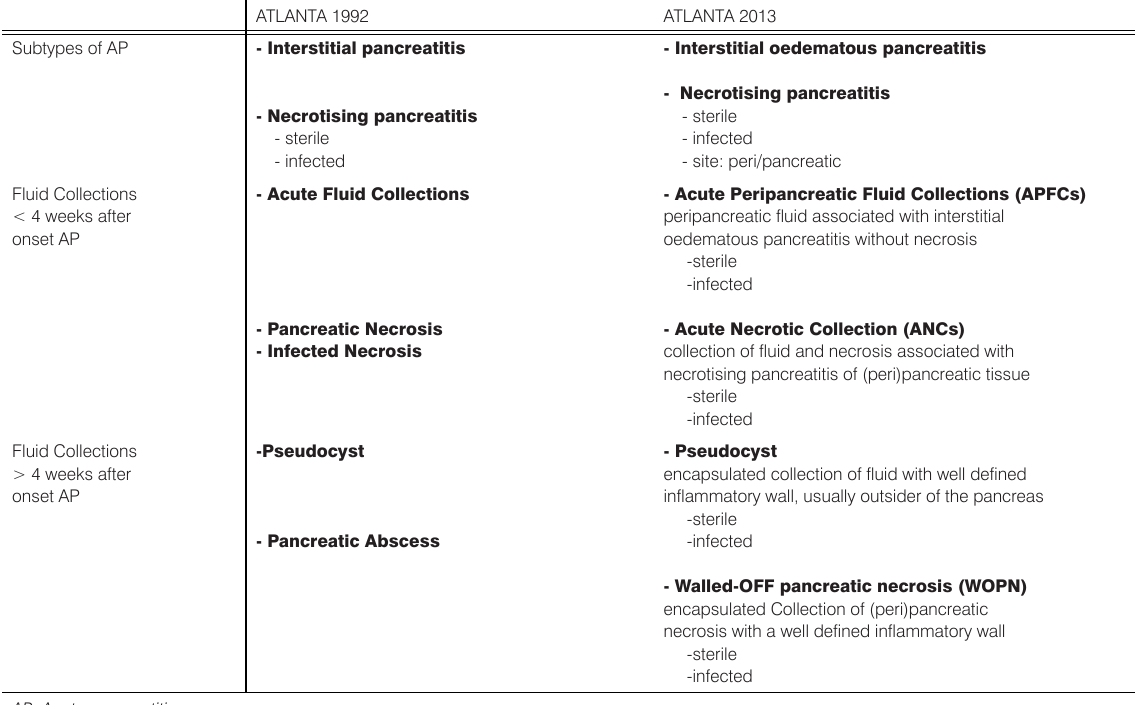
Table 1. Comparison of terminology of AP: Atlanta Classification vs Working Group